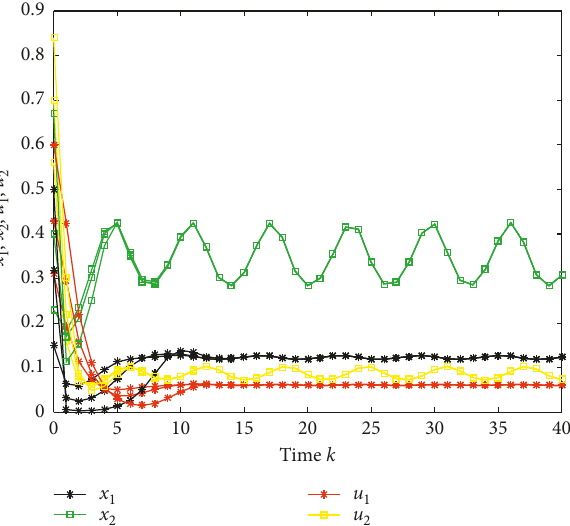
Figure 1: Numeric simulations of the solutions x s ,x s ,u s ,u s 1 ( 2 ( 1 ( 2 ( ( ) ) ) ))(cid:31) (